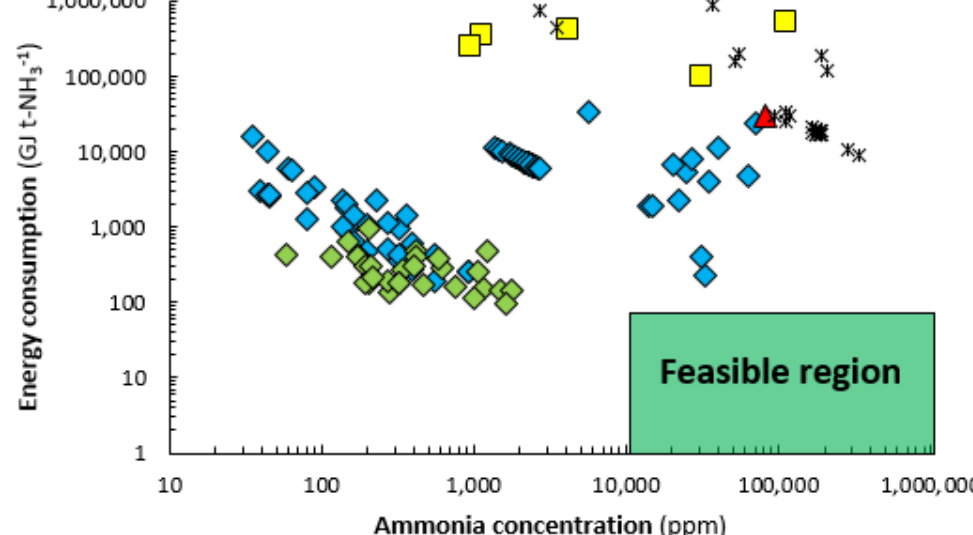
Figure 2. Reported energy yield vs. ammonia concentration at various process conditions. Constructed